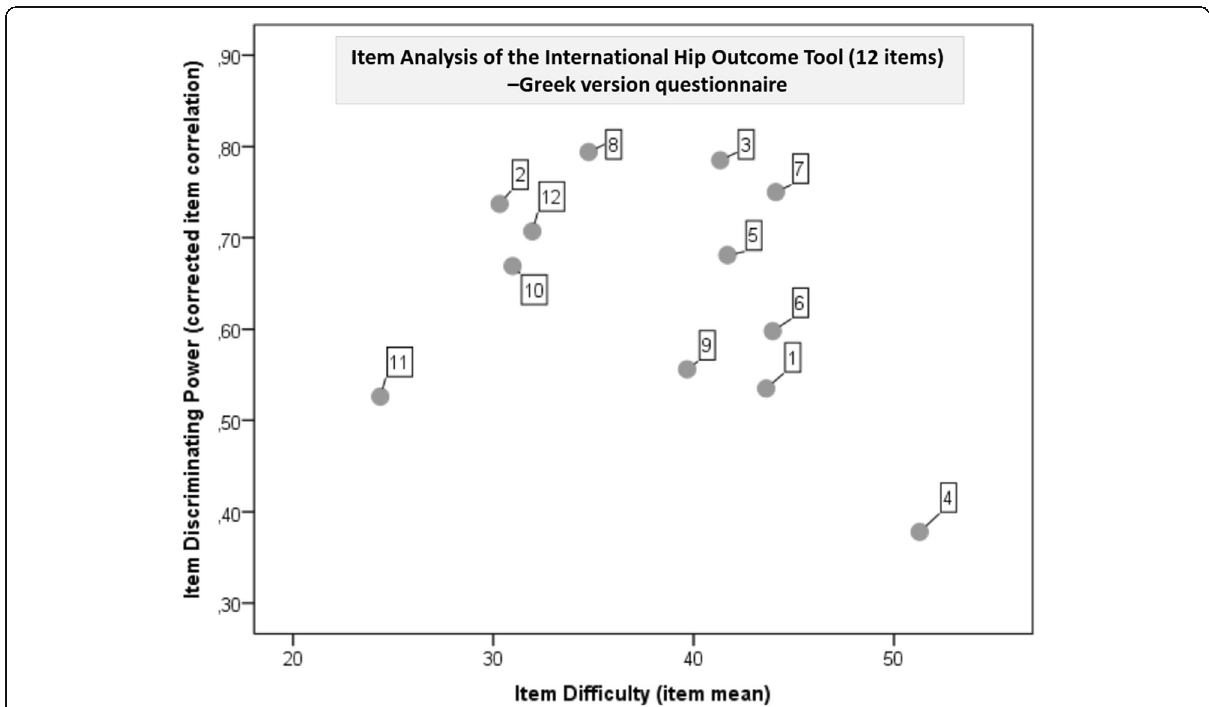
Fig. 3 The item discriminating power (corrected item correlation) and the item difficulty (item mean) depicted by the explanatory data analysis of International Hip Outcome Tool – Greek version